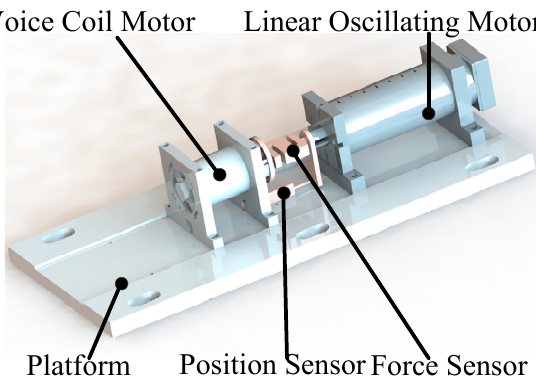
Figure 9. 3D structure of linear oscillating loading system.